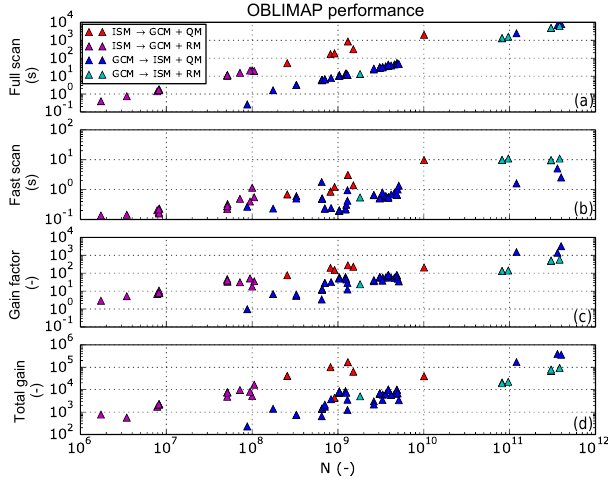
Figure 6. In all, 60 mapping experiments representing a diverse set of mappings which differ in number of nodes, grid resolution, mapping direction, interpolation method, location and thus also in projection, have been used to compare the time performance of the full scan method (a) and the fast scan method (b) as function of N , the number of participating destination grid points multiplied by the number of departure grid points. Panels (c, d) show the gain factor if the fast scan method or the fast mapping per individual 2-D field is used instead of the full scan method. Four colours distinguish be- tween experiments that differ in mapping direction and use either the quadrant interpolation method (QM) or the radius interpolation method